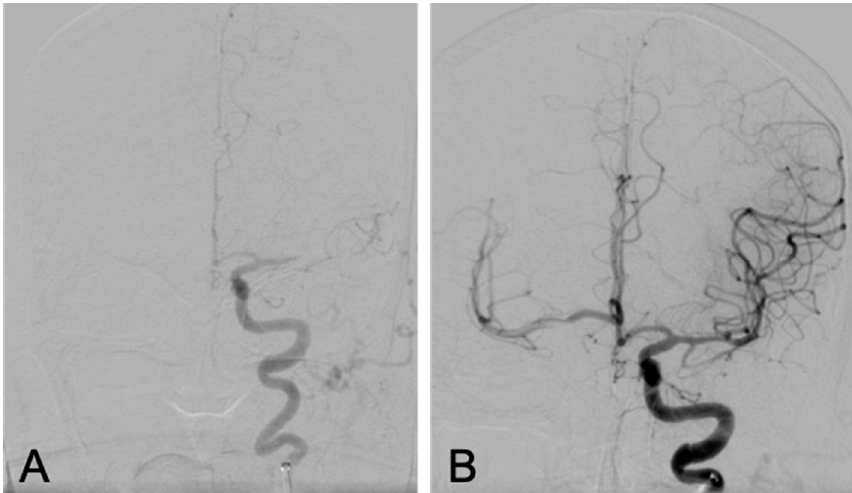
Figure 2. Second Thrombectomy, PA views: left M1 middle cerebral artery occlusion before ( A ) and after ( B ) successful mechanical thrombectomy.